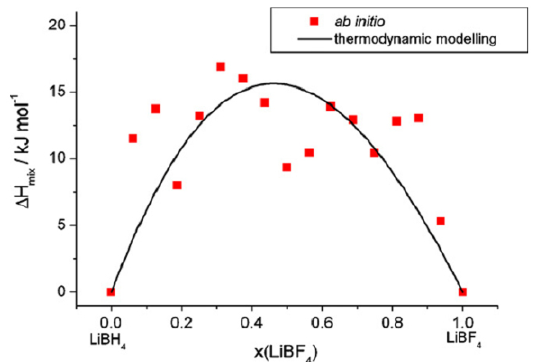
Figure 4. Calculated excess enthalpy of mixing as a function of composition in the orthorhombic LiBH solution at 298 K and 1 bar (line) in comparison with the results from first-principles calculations